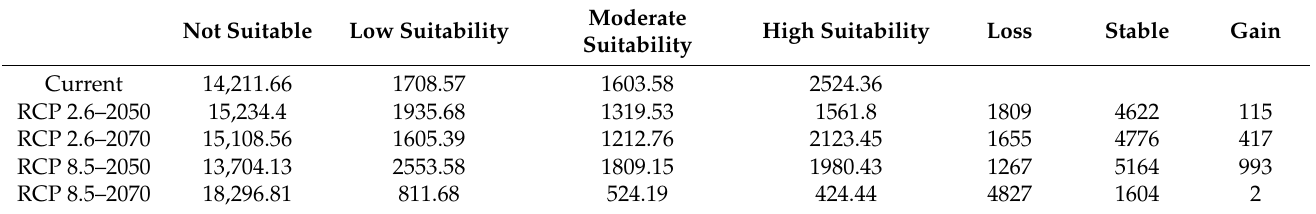
Table 3. Areas (km 2 ) of habitat suitability for Persian oak ( Quercus brantii ) in the west of Iran under current and future climatic